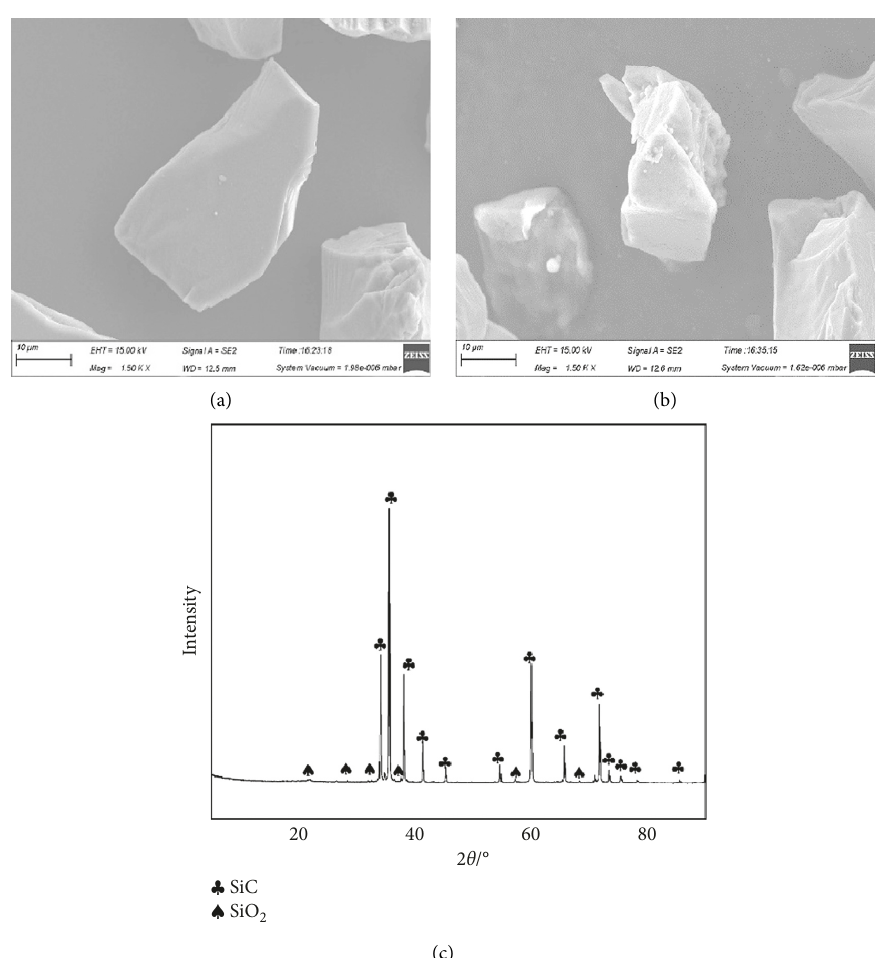
Figure 1: Microstructure of the SiC particles: (a) untreated and (b) oxidation-treated; (c) X-ray diffraction of SiC particles after oxidation